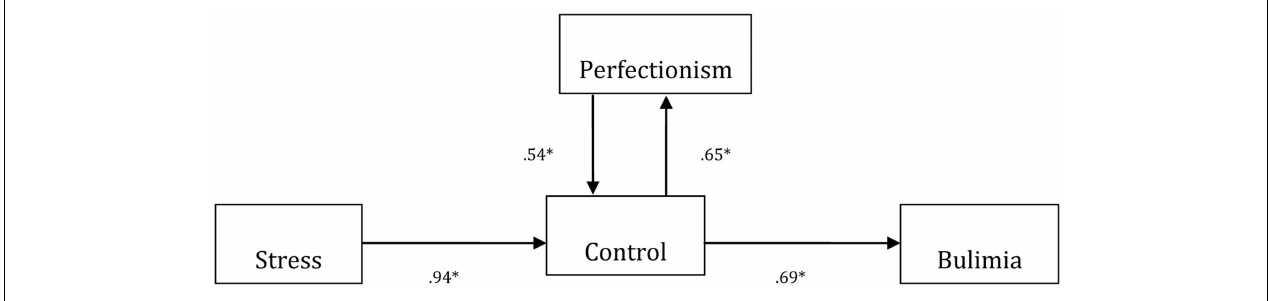
FIGURE 2 | The estimated model of Perfectionism, Control, and Stress on Bulimia. Please note that standardized coefficients are presented. For ease of presentation, error terms were